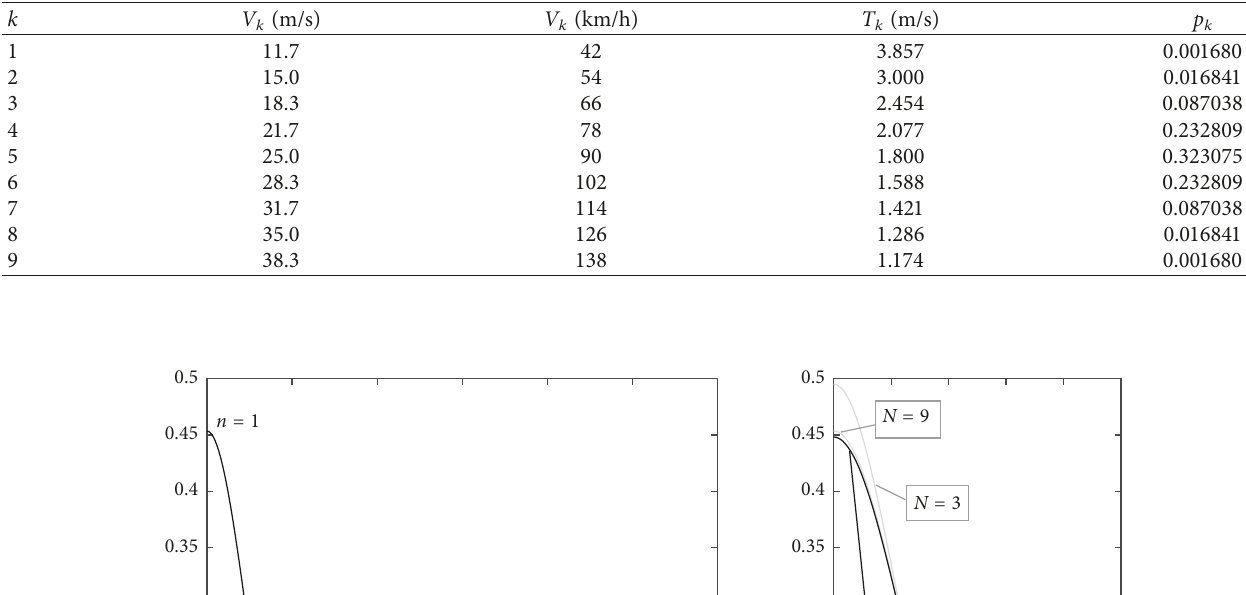
Table 1: Discretization of crossing speeds distribution, with N � 9.